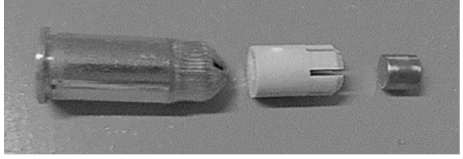
Figure 4. Projectile assembly of the ballistic impacts.